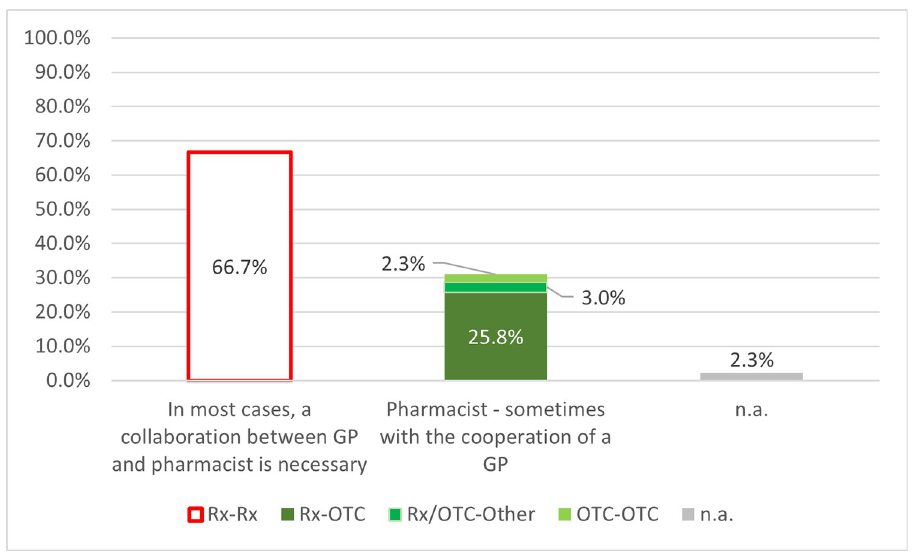
Fig 3. Frequency of interaction risks grouped by the competent healthcare professional providing the necessary intervention and a complete solution, and by the prescribing and dispensing category of the drugs involved. Rx: Prescription drug; OTC: Over-the-counter medicine; Other: Other products (e.g. dietary supplements); n.a.: Not available; n = 531.